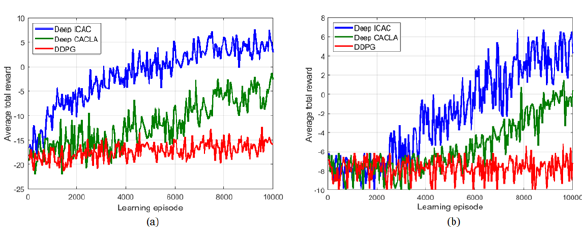
Figure 8: Learning curves of Deep ICAC, Deep CACLA, and DDPG on the robotic environment of the learning-to-grasp task in different re- ward settings: dense-reward (a) and sparse-reward (b). The average over 50 episodes is shown for